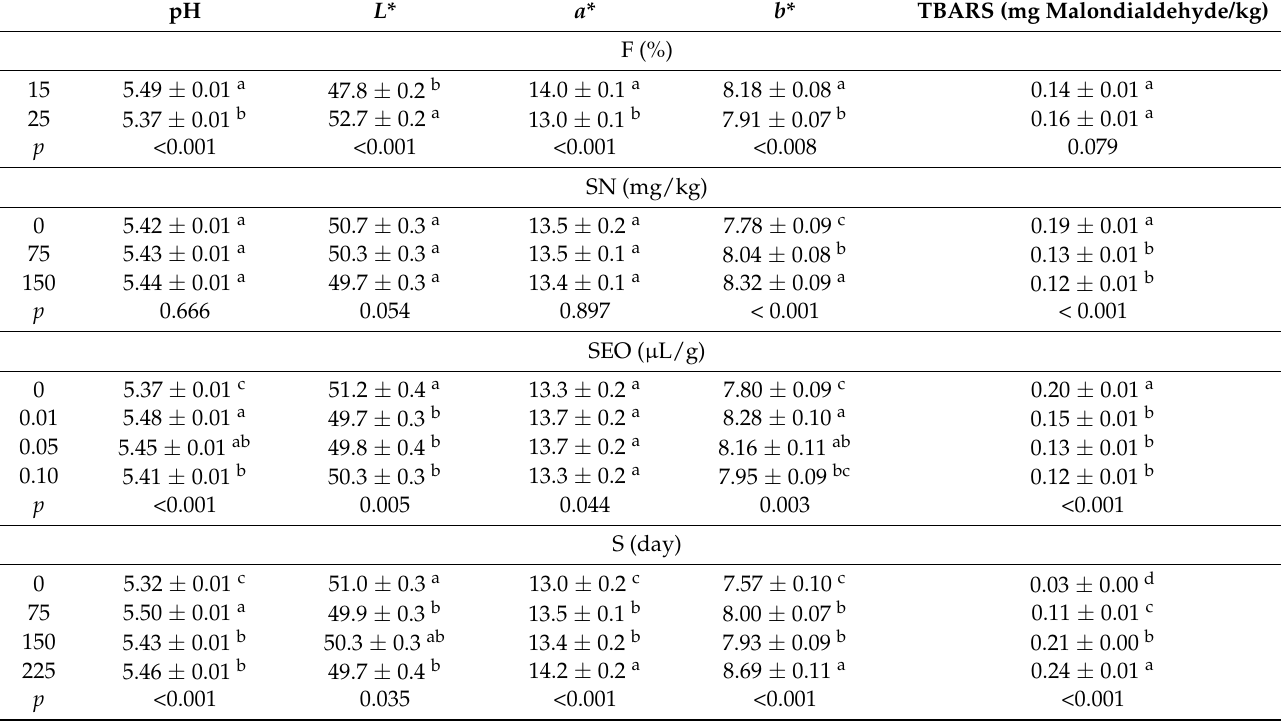
Table 3. pH, instrumental parameters of color and 2-Thiobarbituric acid reactive substances (TBARS) values of DFS.